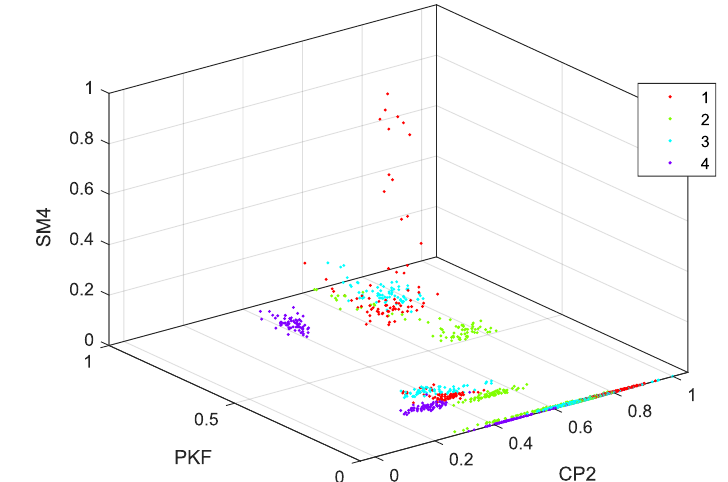
Figure 6. Scatter plot using 3 best CIs of